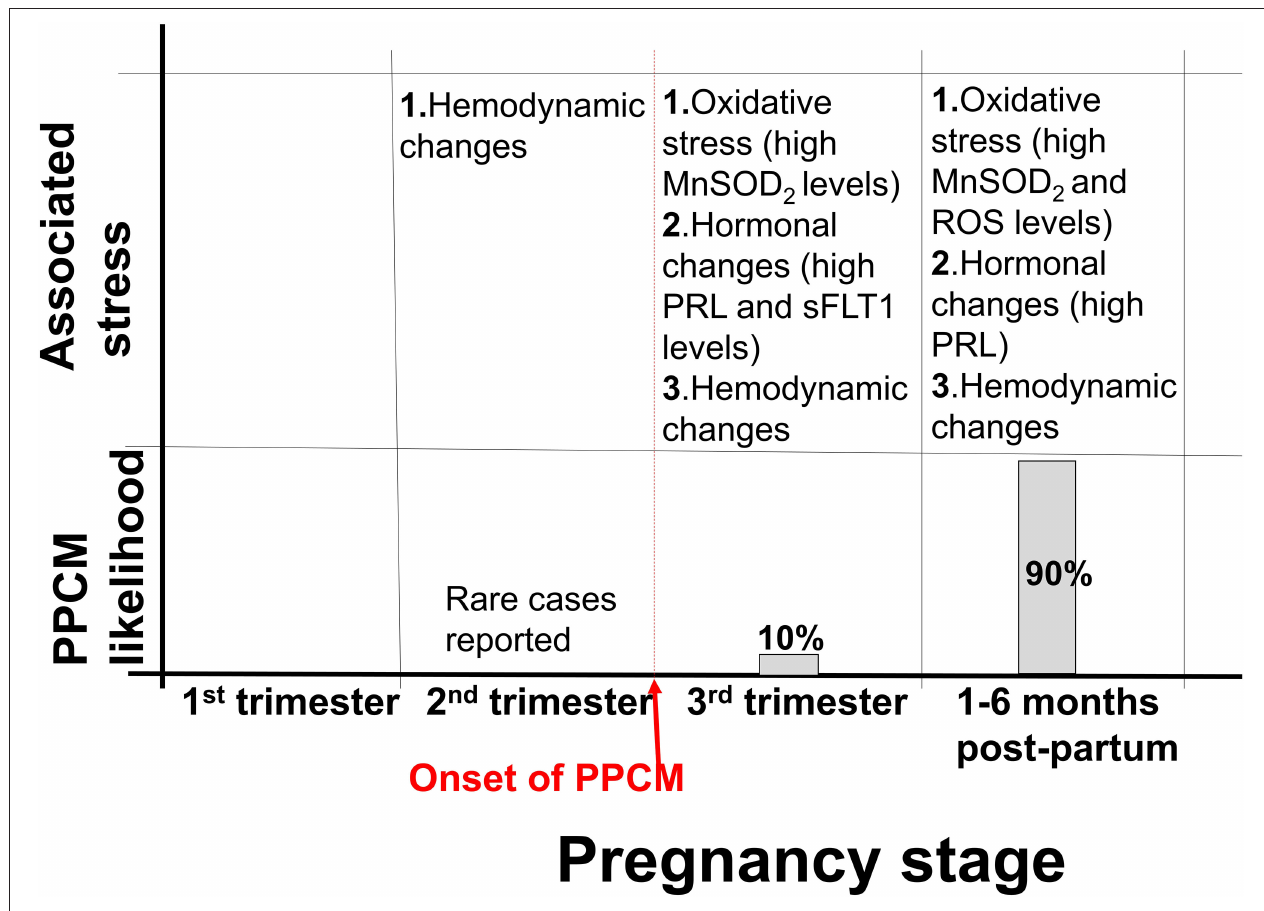
FIGURE 1 | Stress associated with PPCM development. Approximately 10% of PPCM cases present within the third trimester, while 90% of PPCM cases present postpartum. Hemodynamic changes associated with pregnancy begin in the second trimester and persist to approximately 6 months postpartum. Several other stresses, such as hormonal changes are also associated with